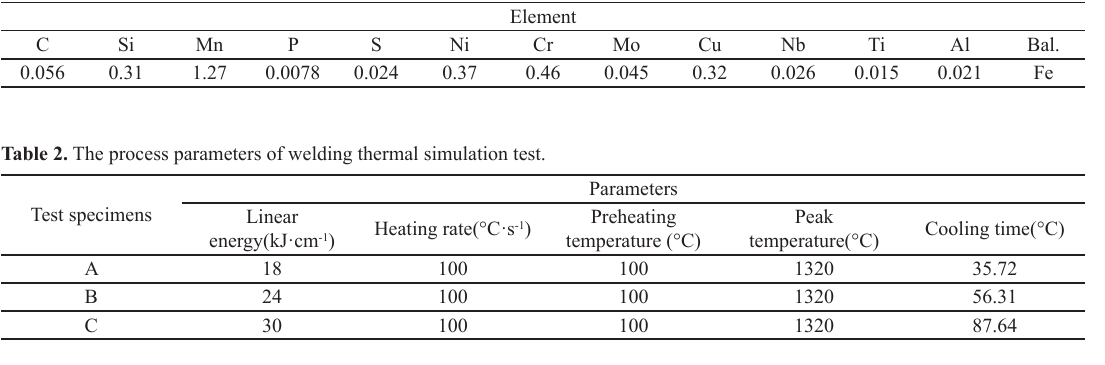
Table 1. Chemical composition of Q420QEN steel.